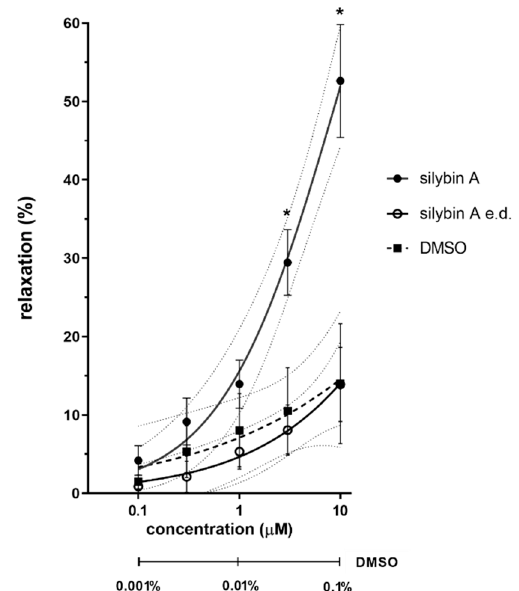
Figure 4. Role of endothelium in vasorelaxant activity of silybin A. The effect was studied on intact or endothelium-denuded (e.d.) rat aortic rings precontracted with phenylephrine. Data are expressed as means ± SEM, n = 4. The concentration of DMSO is shown below the x axis. * p <0.05.